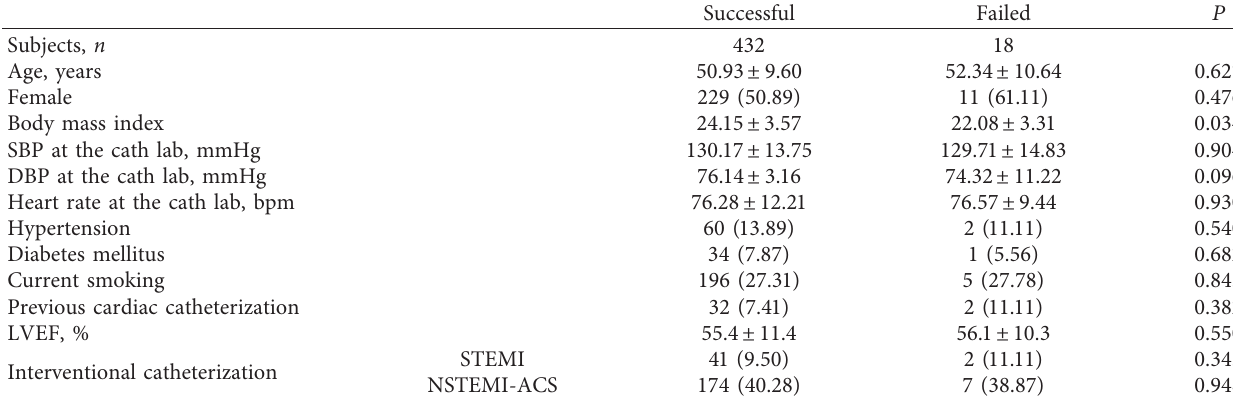
Table 3: Characteristics of successful and failed cannulation in patients receiving dTRA ∗